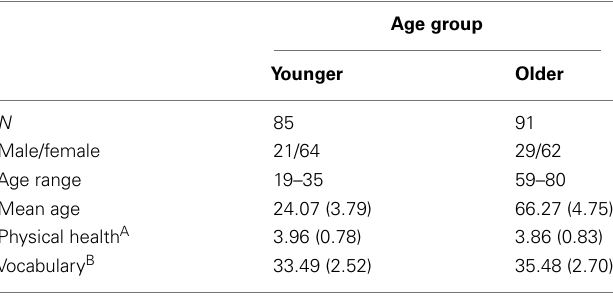
Table 1 | Descriptive statistics for the participants: gender distribution, age range, and means ( SD ) for age, physical health, and